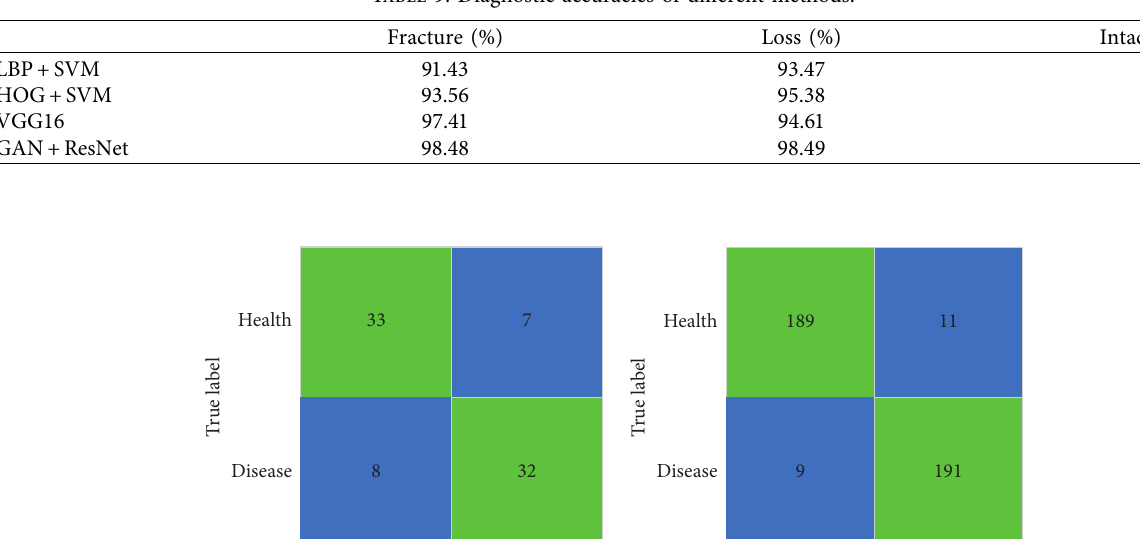
Table 9: Diagnostic accuracies of different methods.